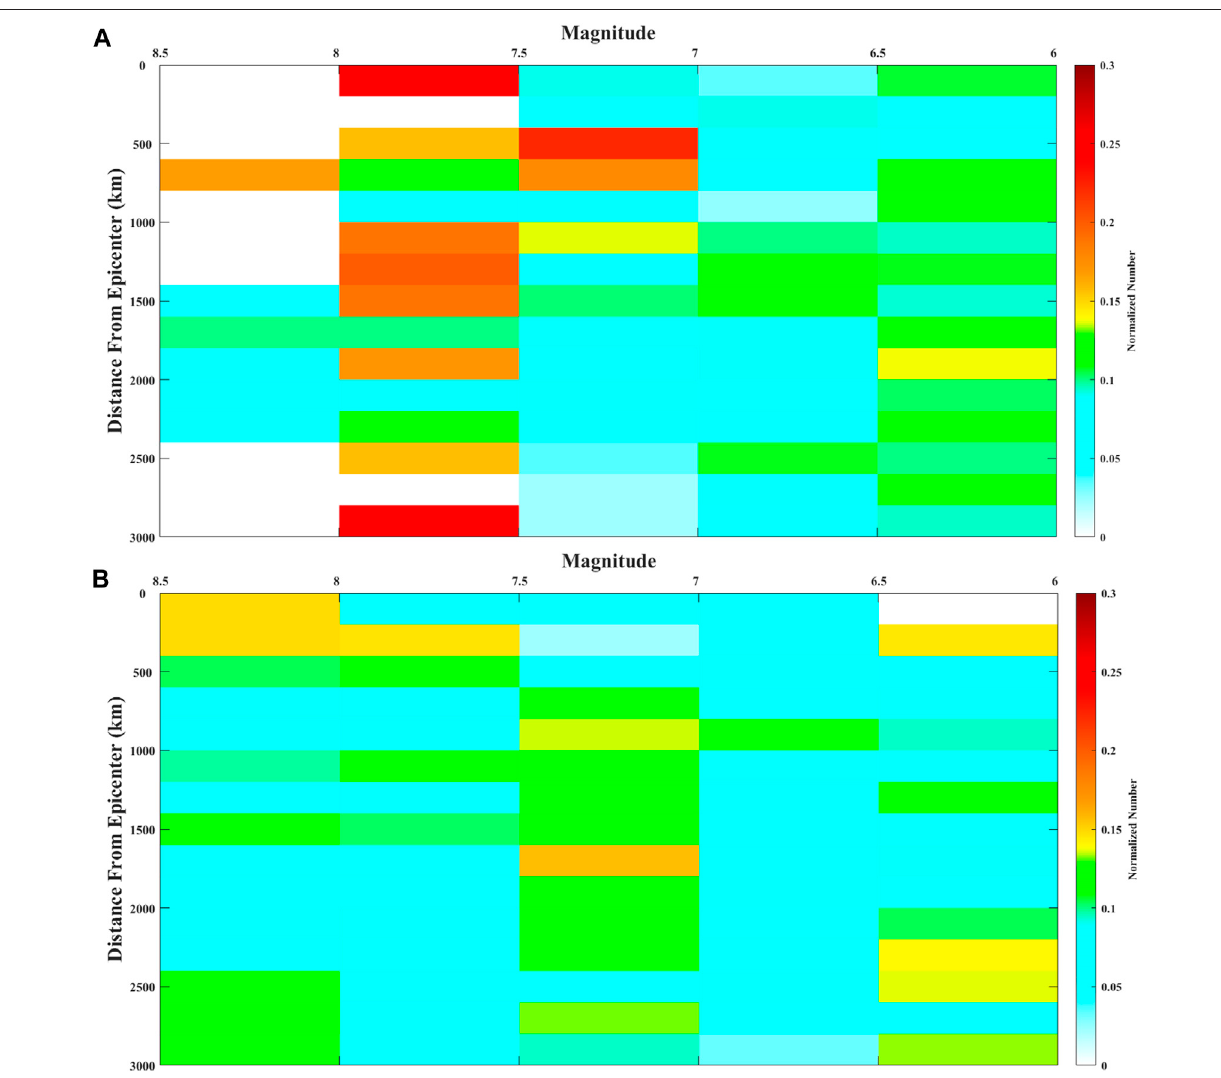
Frontiers in Earth Science |